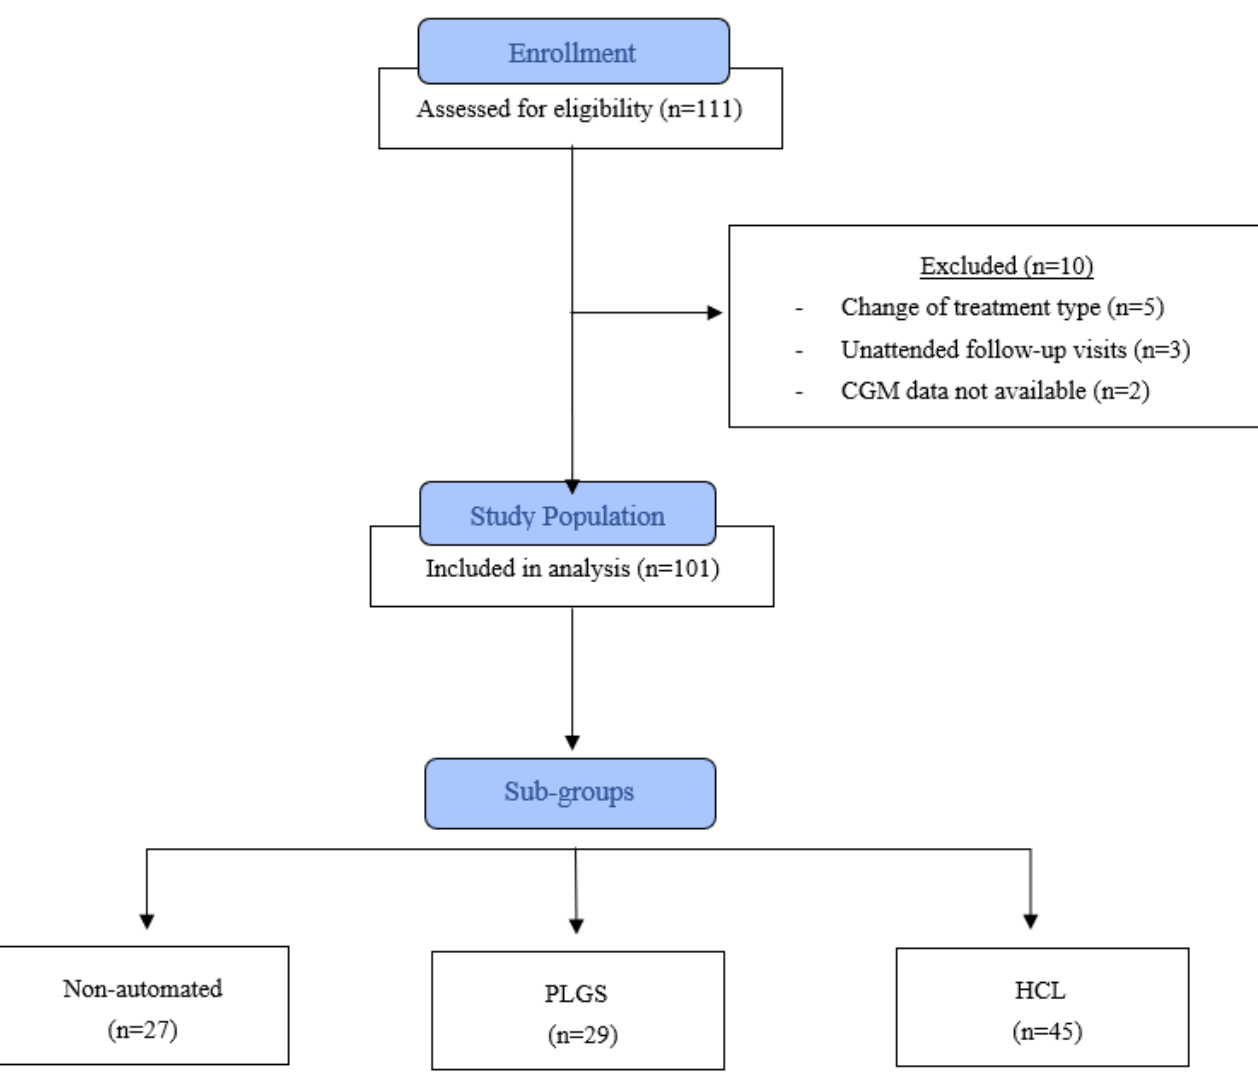
Figure 1. Flow diagram for patient recruitment.